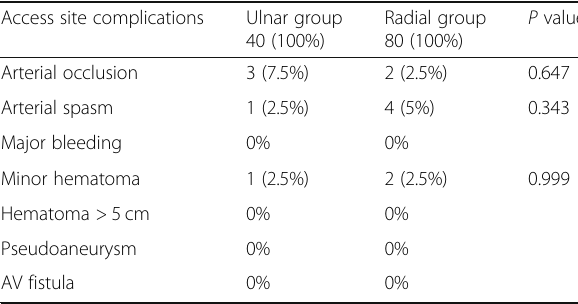
Table 4 Distribution of complications in both groups: